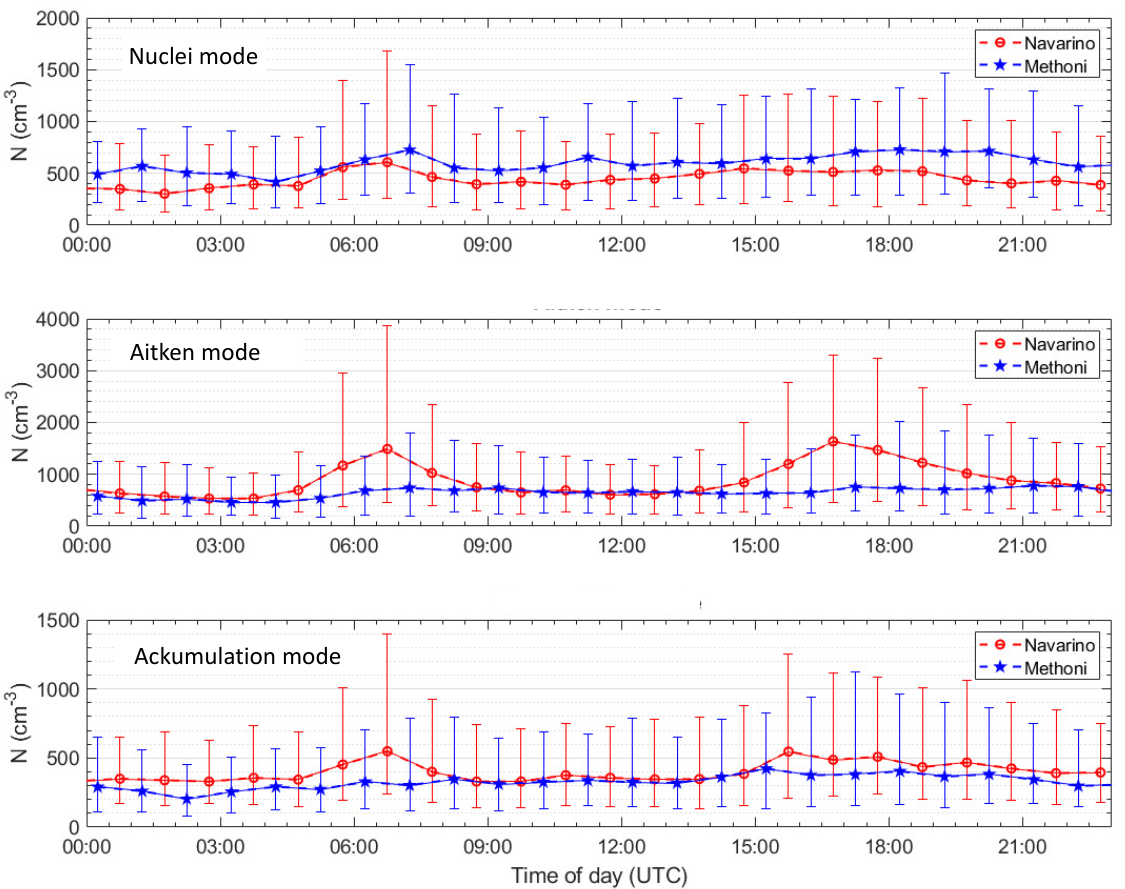
Figure 8. Diurnal variation of number concentration of nuclei, Aitken and accumulation modes for the cold period November–March at Navarino (observations for the period April 2011–September 2013) and at Methoni (observations for the period November 2013–December 2016). The dotted curves indicate the median values while the error bars indicate the inter-quartile range.